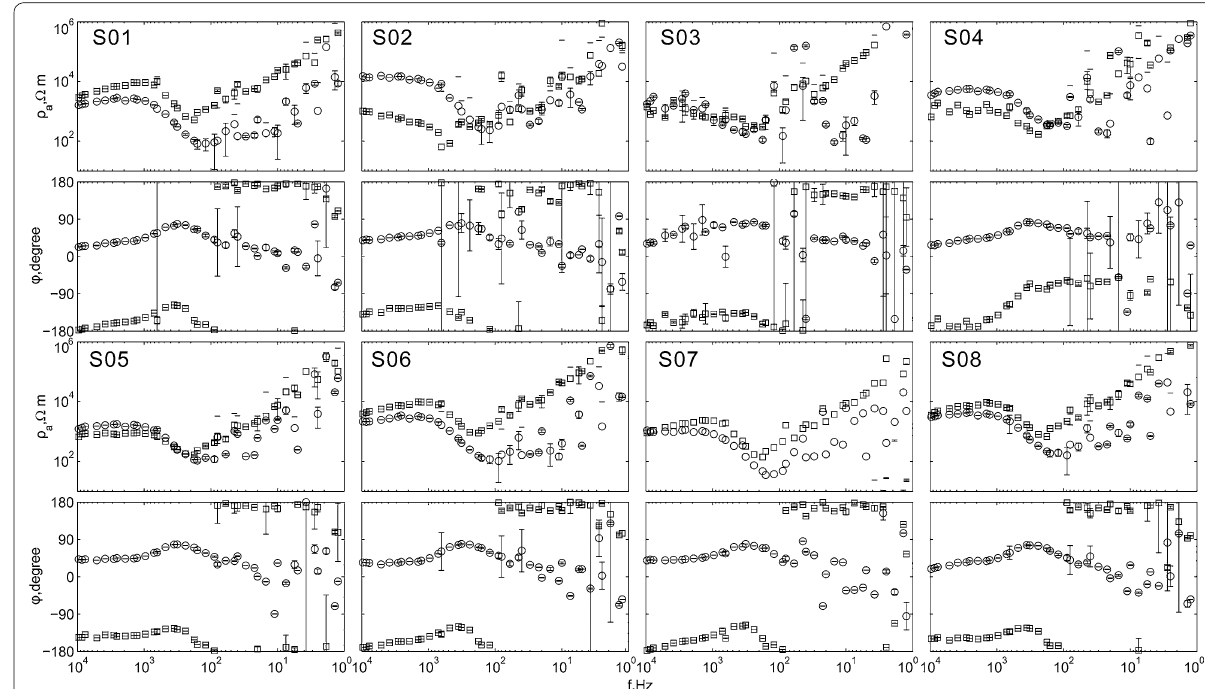
Fig. 15 Tensor CSAMT method module sounding curves in the mine area with strong human activity